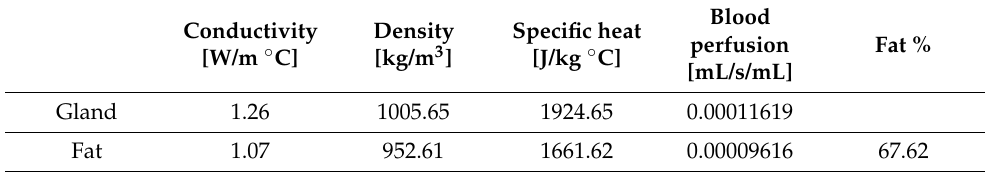
Table 9. Estimated specific breast parameters (patient #3).